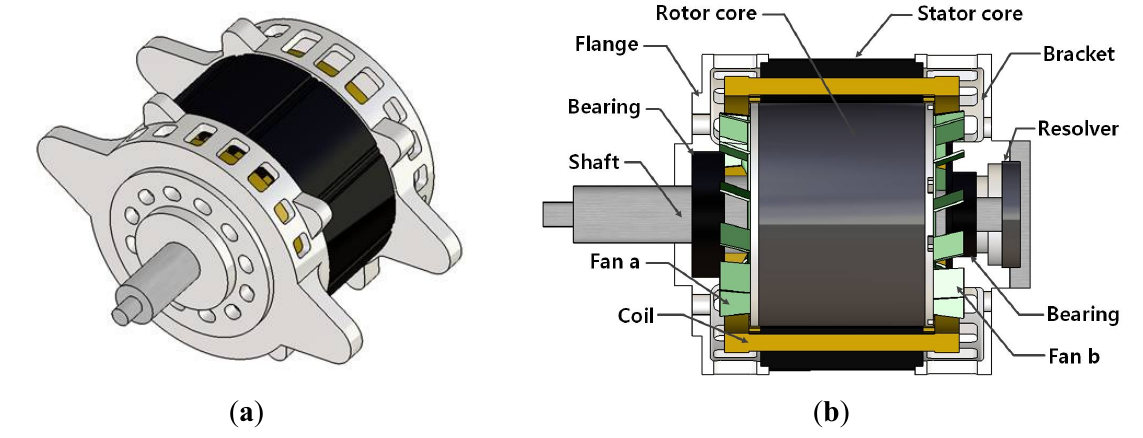
Figure 2. External and internal views of the ISG. ( a ) External view. ( b ) Internal